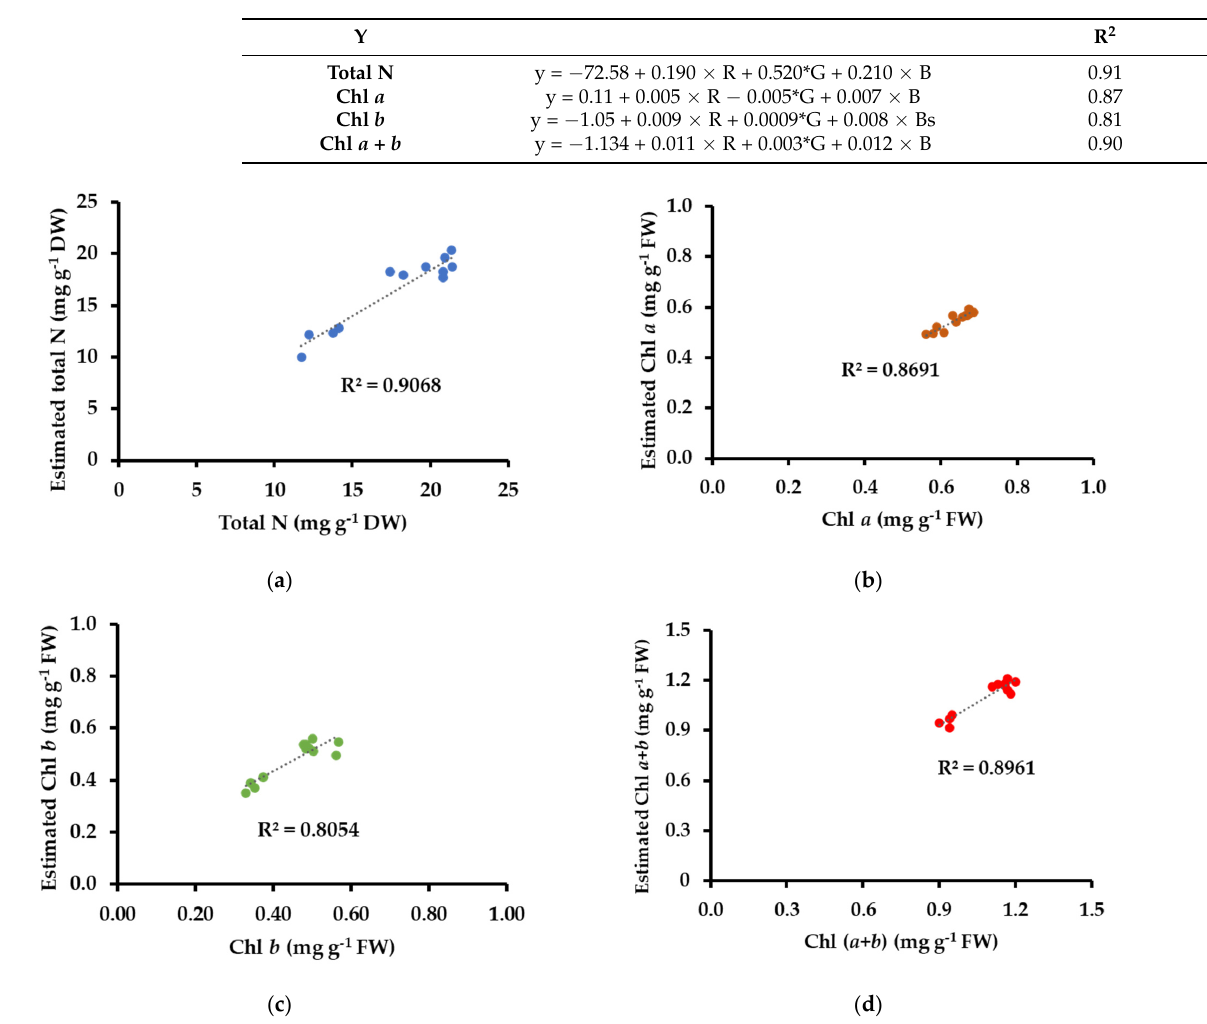
The values in bold correspond to the values higher than 0.60 at p < 0.05. Table 7. Equations and coefficient of determination (R 2 ) for the linear regression value between total N, Chl a , b and a + b (Y), and R, G, and B (X) in R. officinalis.